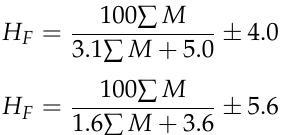
Figure 9. Displacement deformations of the roadway under different coal-pillar widths.